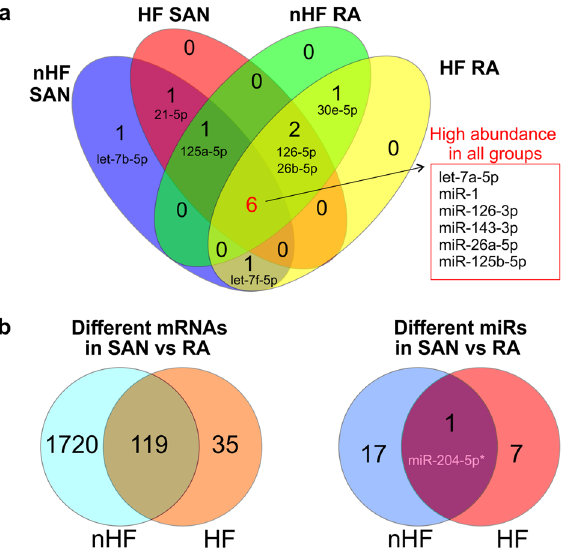
Figure 7. Similarity of miR and mRNA profiles in SAN vs RA in HF and nHF hearts. ( a ) Top 10 most abundant miRs revealed by NGS in each HF-RA, nHF-RA, HF-SAN, and nHF-SAN groups. ( b ) Comparison of significantly different mRNAs (left) and miRs (right) in the SAN vs RA between control and HF groups. HF indicates heart failure; NGS, next generation sequencing; RA, right atrium; SAN, sinoatrial